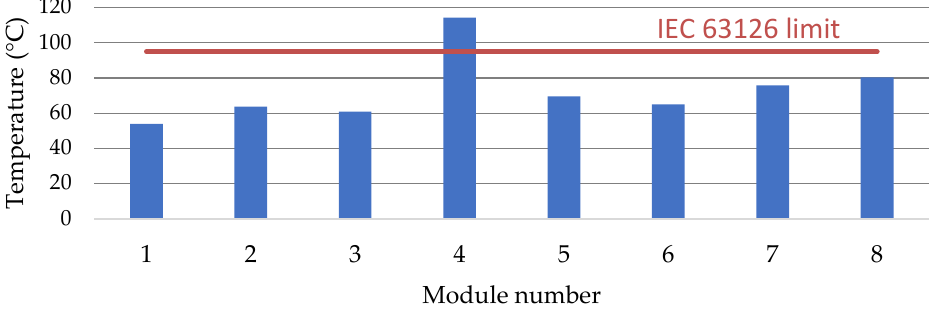
Figure 27. Maximum temperature values of the module surface.